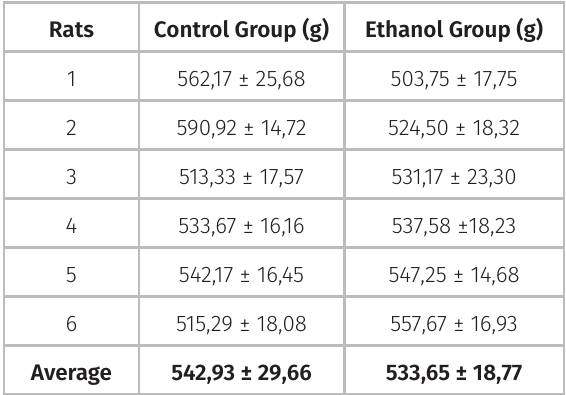
Table I. Mean ± standard deviation of body mass of rats in grams (g).